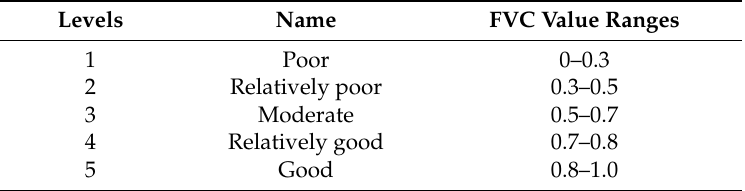
Table 1. Classification of FVC degrees.